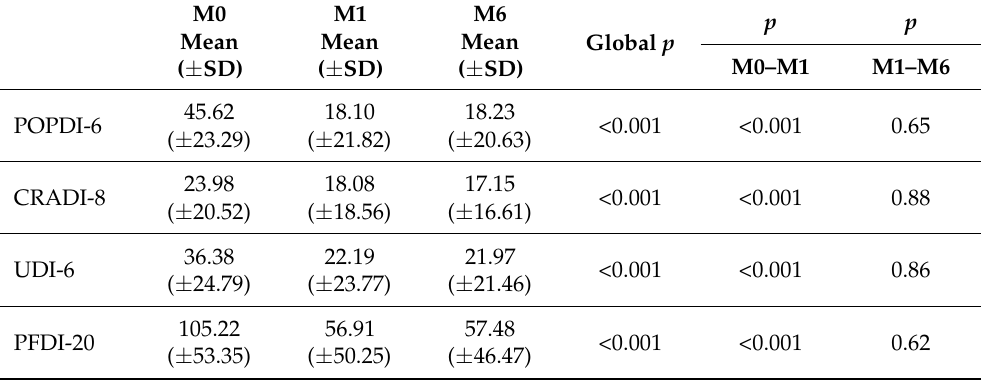
Table 3. Changes in women’s symptoms and quality of life using mixed effects